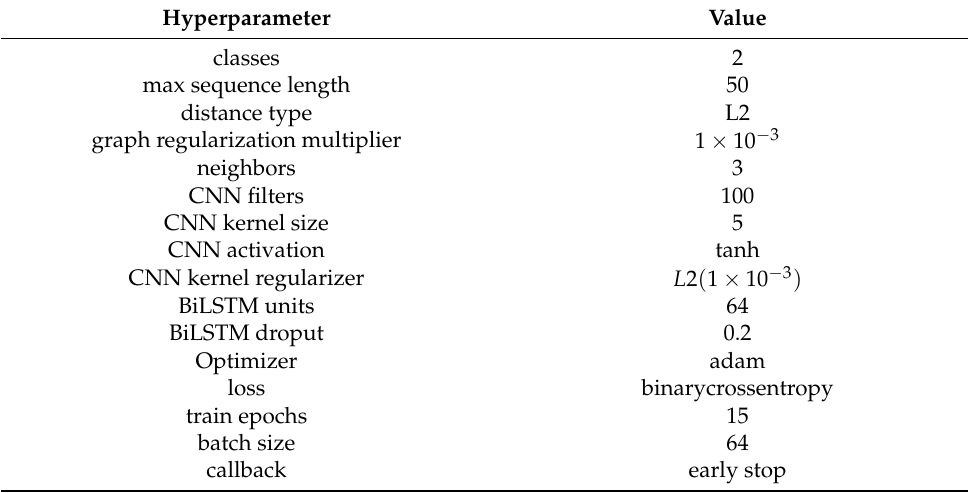
Table 4. Hyperparameters and constants used for training and